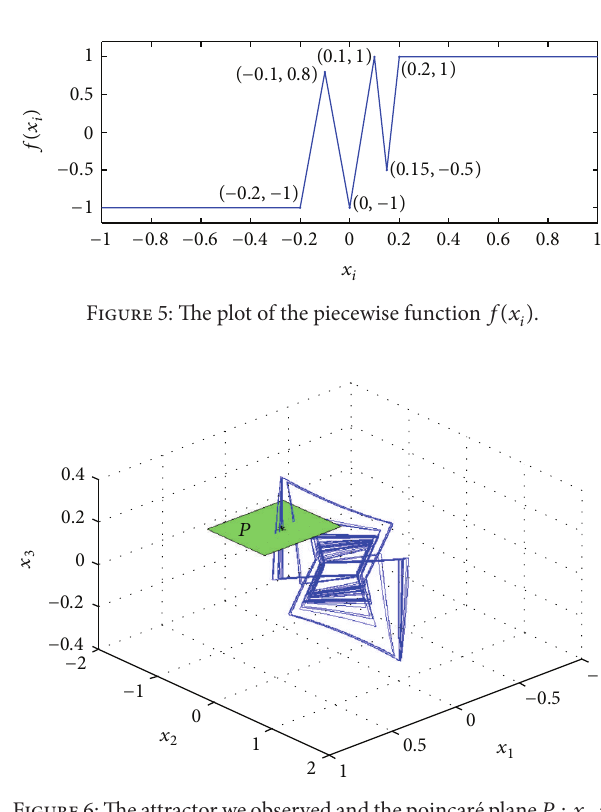
Figure 6: The attractor we observed and the poincar´e plane 𝑃 : 𝑥 3 = 0.2